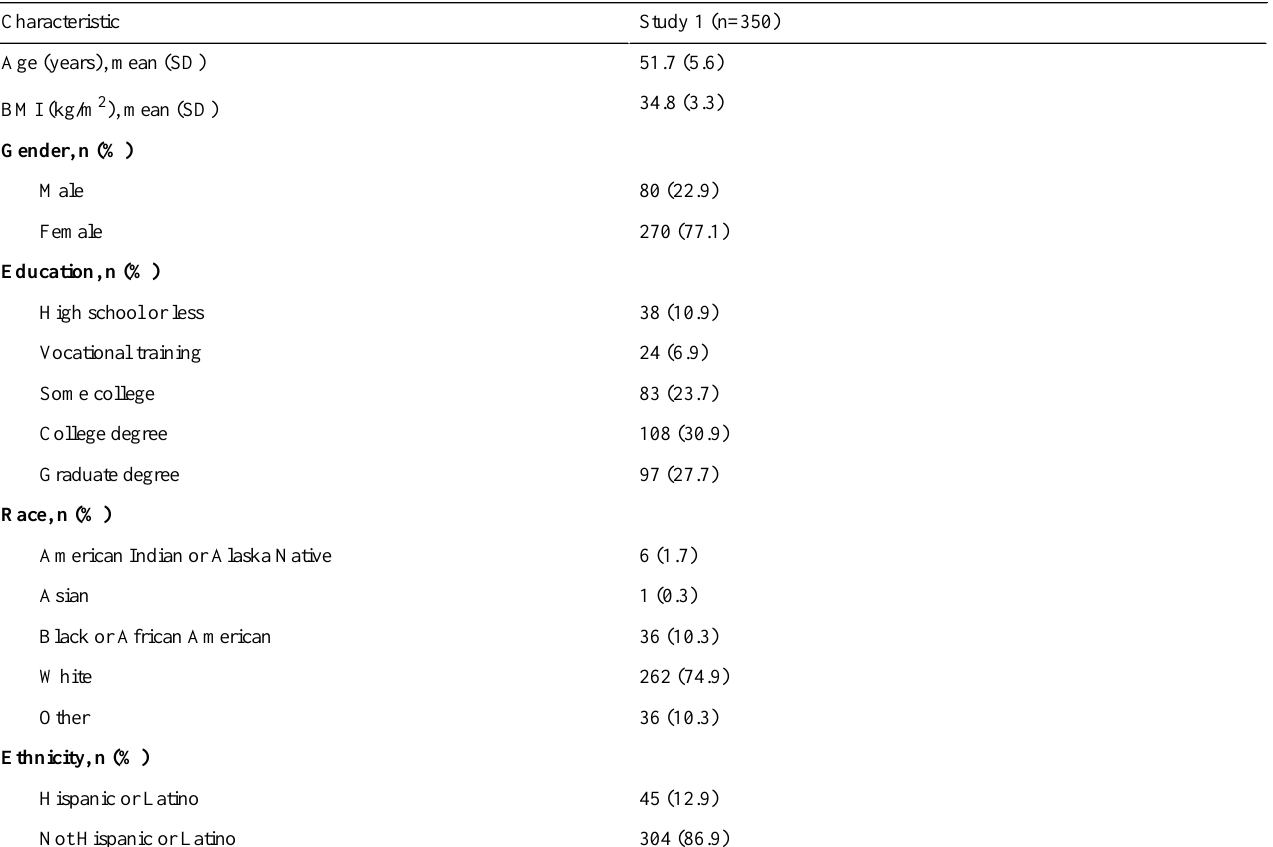
Table 1. Baseline and demographic characteristics of participants in study 1